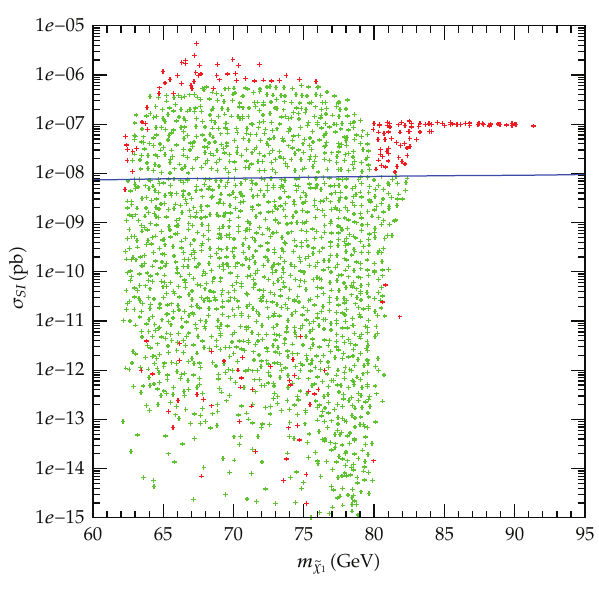
Figure 6: The spin-independent neutralino-proton scattering cross section σ si (cid:2) p (cid:3) as a function of M blue line indicates the bound from XENON100 (cid:5) 47 (cid:6) , and we have added points violating this bound (cid:2) but respecting all the others (cid:3) . The color code is as in Figure